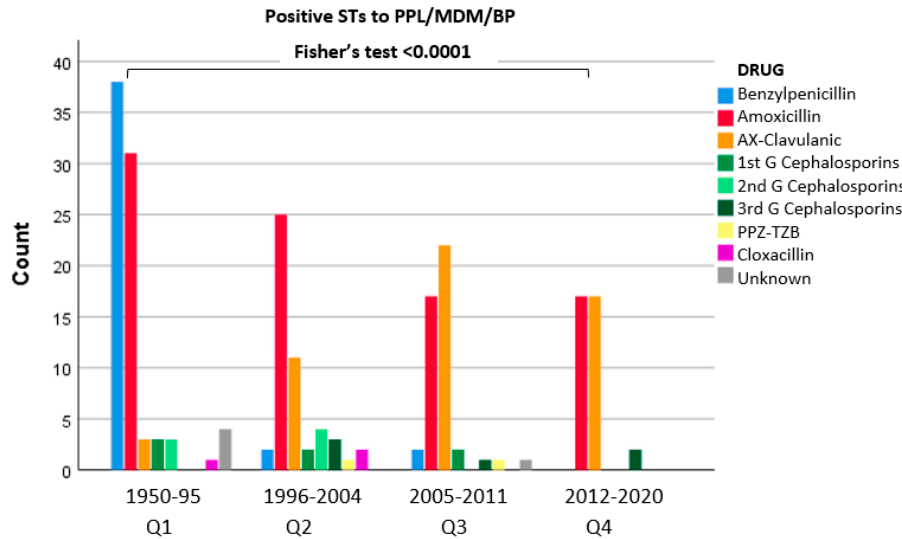
Figure 1. Positive STs with BP reagents related to the eliciting BL.